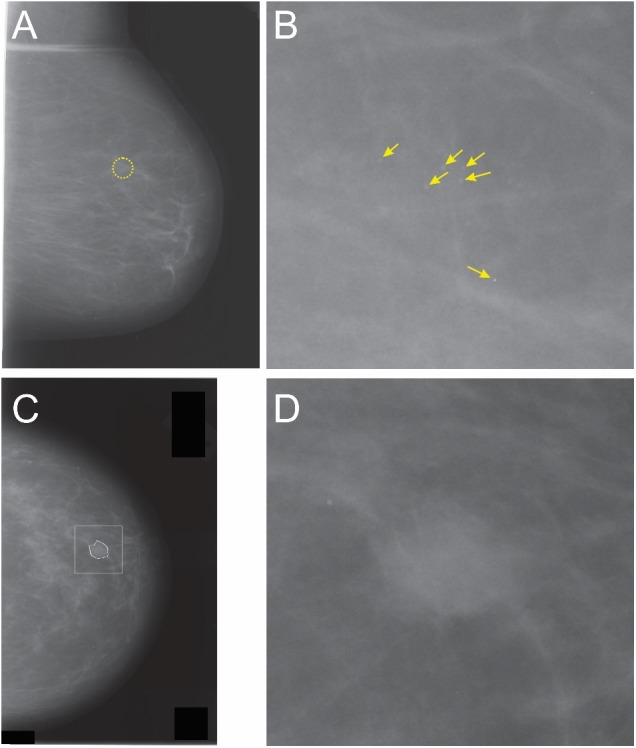
Whole-breast mammograms (A,C) and the corresponding partial view mammograms (PVMs) mammograms (B,D, respectively). The dotted circle in panel A denotes an ROI containing a cancer. Note that the cancerous region accounts for a relatively small portion (<1.4% of the area) of this mammogram, so that the rest of the image contains either healthy breast tissue, or a blank field that contains no breast tissue at all. Thus, diagnostic information in whole-breast mammogram is substantially “diluted.” Panel B shows a magnification-view mammogram of the same ROI that shows multiple microcalcifications (arrows). Note that this image is much enriched in diagnostic information compared to the whole-breast mammogram. It also has a much simpler global structure (or “image grammar,” in machine learning terms), in that it does not have the global information such as the breast outline, chest wall, musculature, etc. The same considerations apply to images in panels C,D. The irregular outline in panel C denotes the radiologically vetted ROI, and the square denotes the image region cropped from C to generate the mammogram fragment shown in D. See text for details.